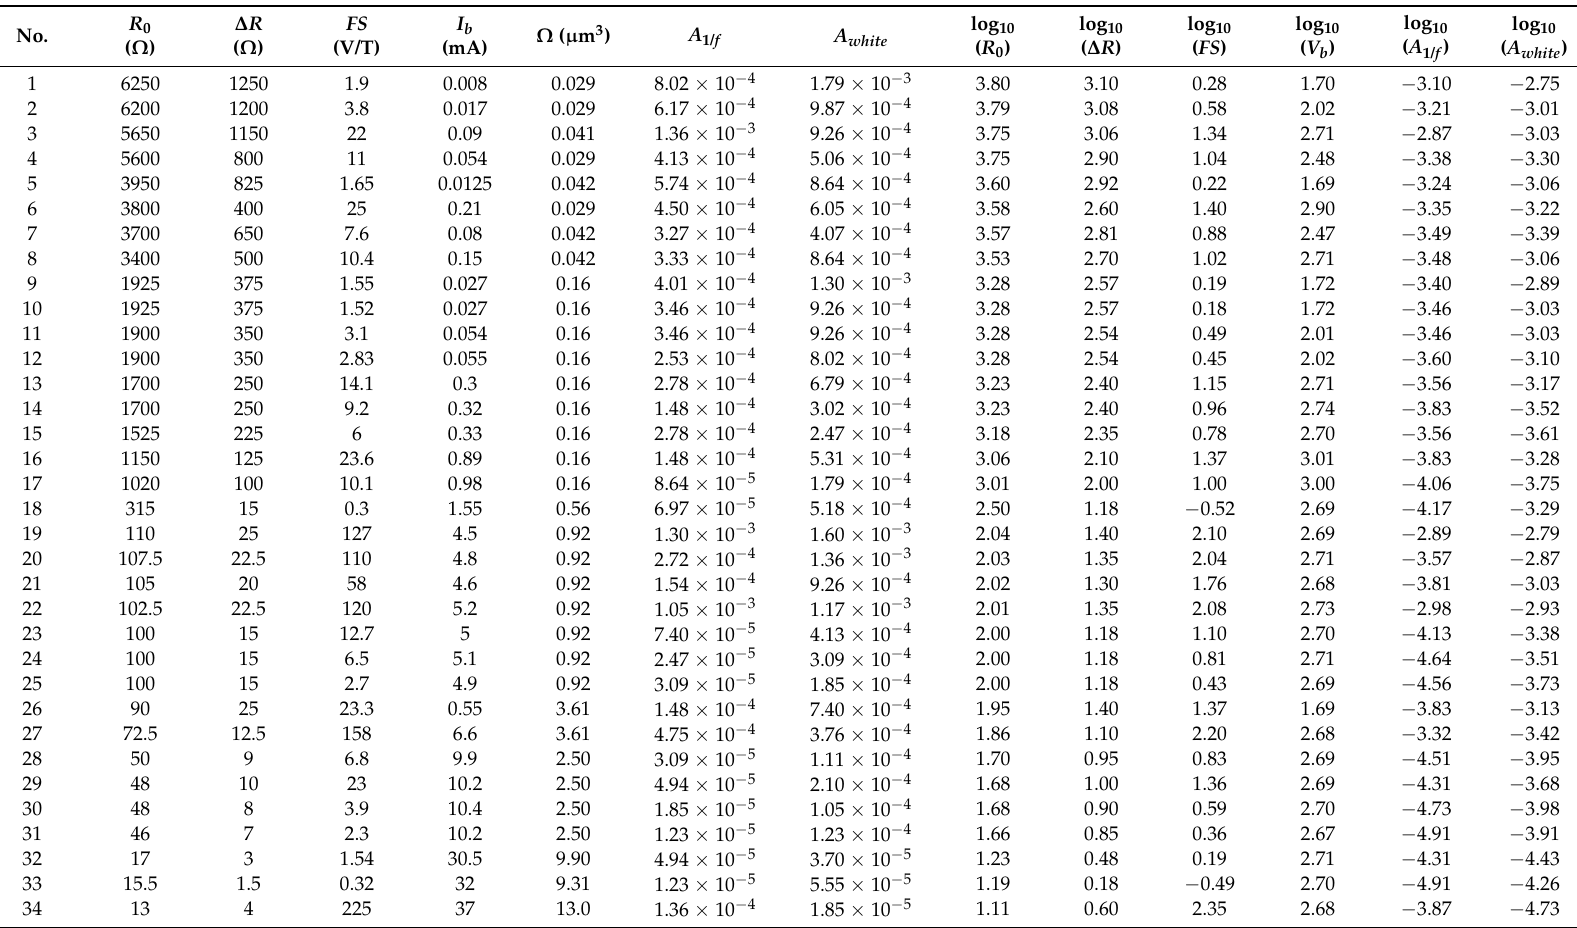
Table A1. Overview of measurement data and fitting results. Before logarithmizing, resistance values were given in Ohms, sensitivity values in V/T and current values in mA. The values of A 1/ f and A white were normalized to 1 µ m 3 volume of the sensing layer.